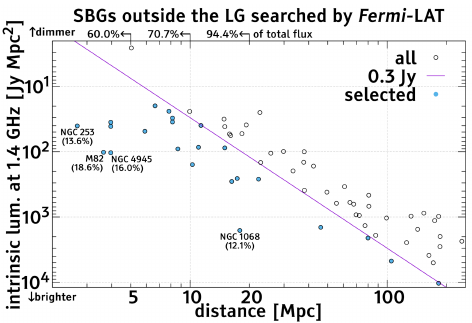
Figure 1. Distances from Earth and intrinsic luminosities of ob- jects listed in Ref. [2], with the ones selected in the Ref. [1] anal- ysis highlighted